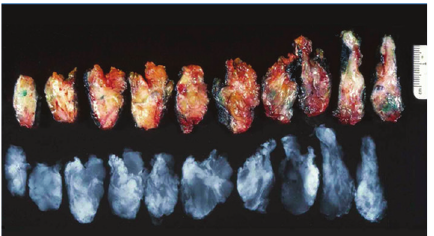
Figure 6: Serially sectioned excision specimen and its Faxitron X- ray. The X-ray image shows a stellate mass in the sixth section from the left with fingers extending very close to the surgical margins. (Image courtesy Dr. A. Sahin, MD Anderson Medical